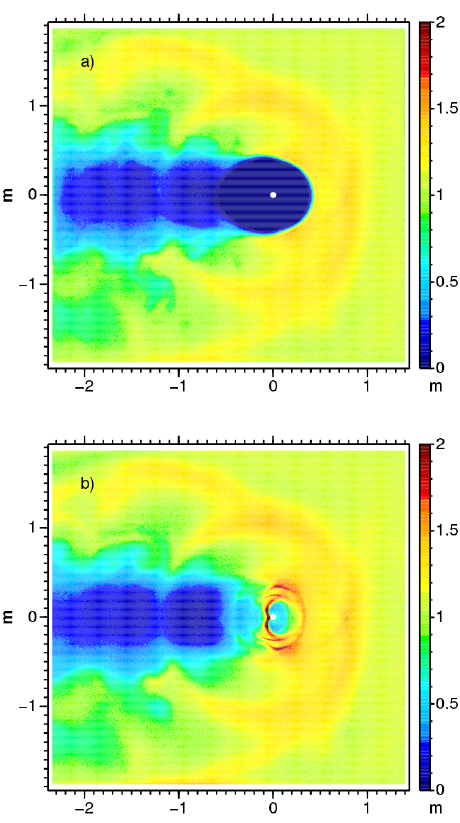
Figure 8. Electron density (a) and ion density (b) normalised to plasma-stream density in the final state ( t = 2 . 43ms) of run Bz.